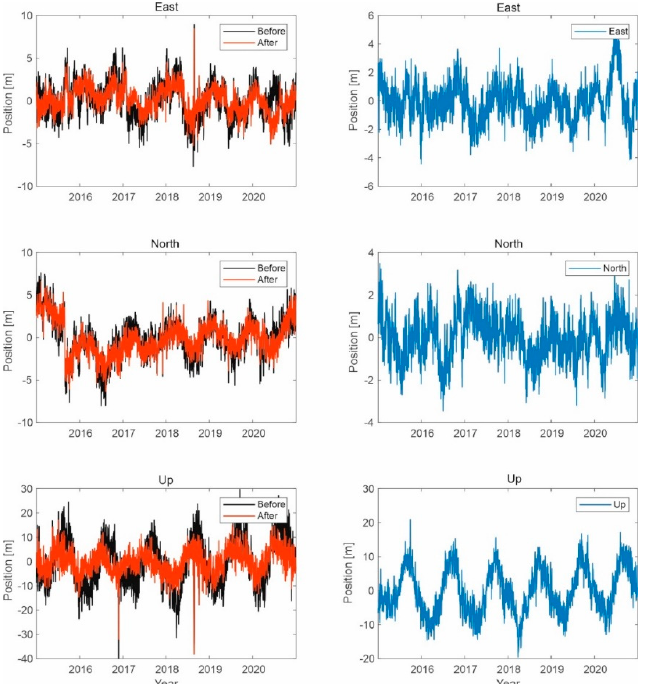
Figure 12. Signal processing in the GPS receiver working on the L1 frequency; on the left side, the signal waveform in color without the noise suppression system applied; on the right side, the working system operating in the LTE system signal elimination for the reception of signals from six satellites.